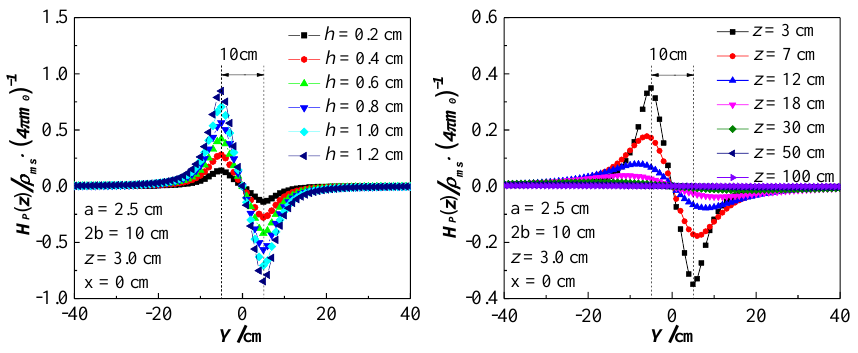
Figure. 7. The theoretical calculation results of Equation (4).